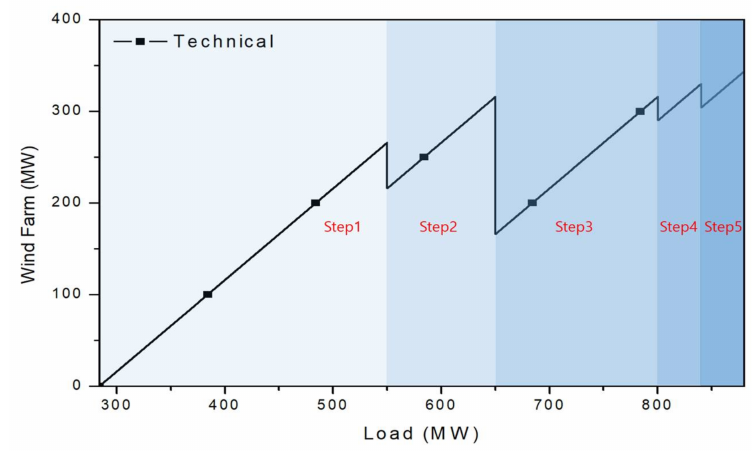
Figure 7. The technical limit capacity of wind farms in Jeju island.